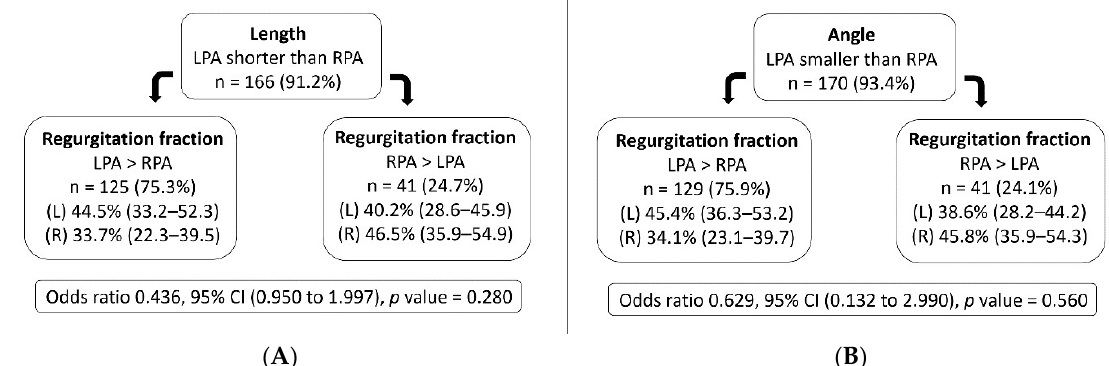
Figure 4. Effect of the length ( A ) and angle ( B ) of the left pulmonary artery on the branch pulmonary artery regurgitation, using linear regression analysis. Regurgitation fraction presented as median and interquartile range (25th–75th percentile).